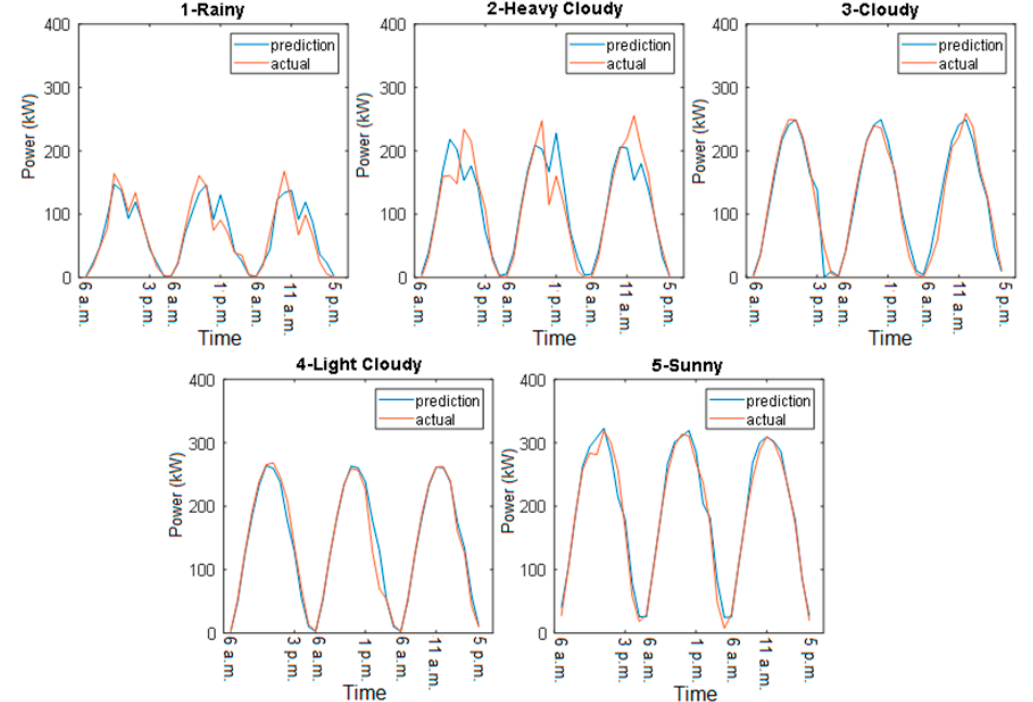
Figure 11. PV power forecasting result: three days ahead.